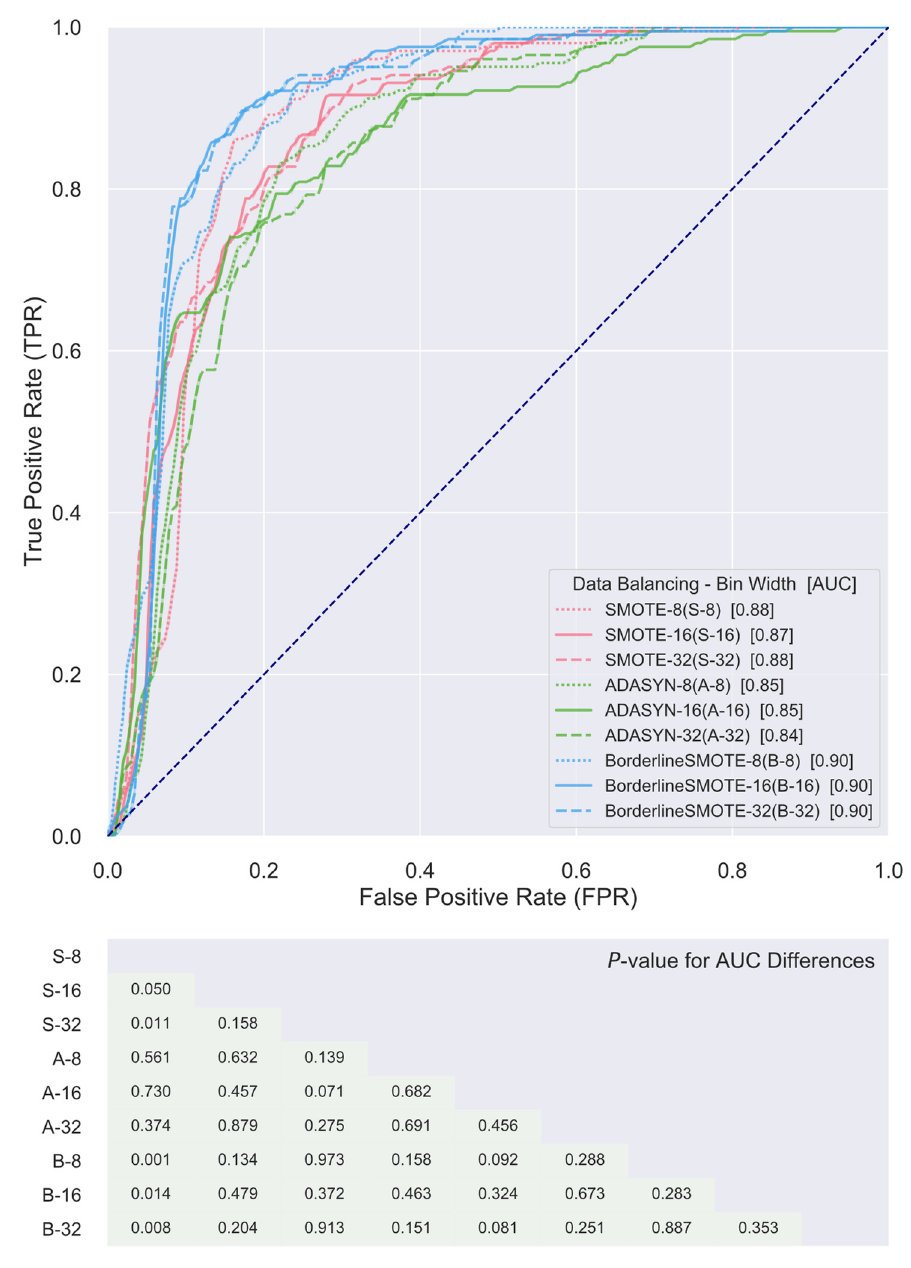
Figure 5. Receiver-operating characteristic (ROC) curve comparisons between support vector machine (SVM) classifiers utilizing the top five consensus radiomics features for each of the data balancing algorithms in differentiating cohorts with and without distant metastasis. The diagonal dash line from the bottom left to the top right corners represents the random classifier, to which the closer an ROC curve approximates, the less powerful in differentiating the two cohorts is the corresponding classifier.